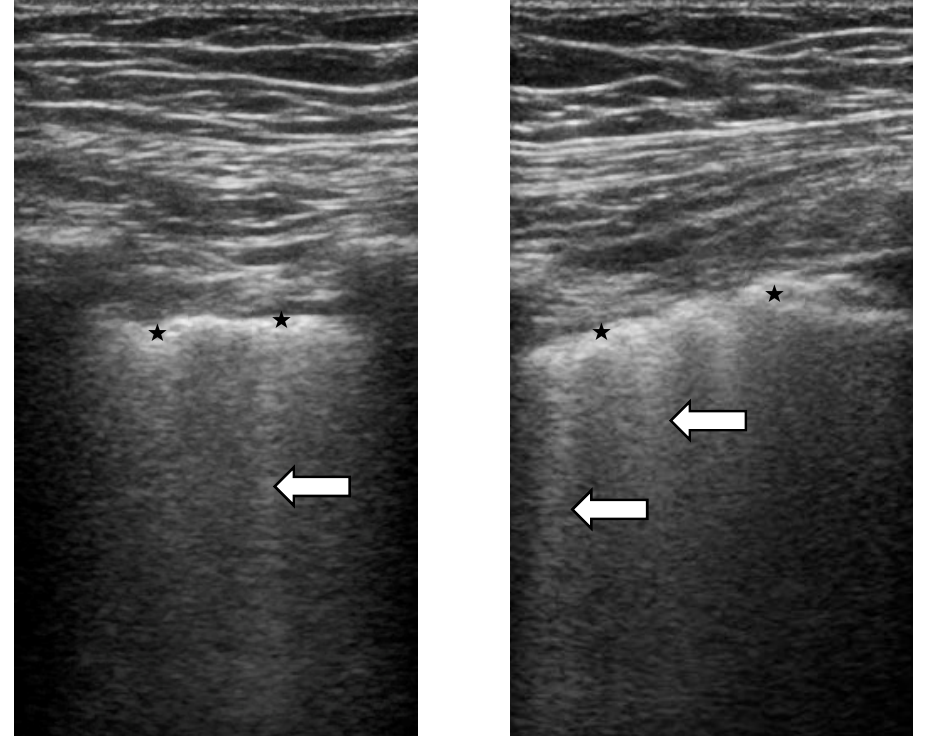
Figure 4. Ultrasonographic scans (4–13 MHz broadband linear transducer). Ultrasound B-lines (or comet-tails) are defined as hyperechogenic artefact consistent with thickened subpleural interlobular septa (white arrows). They originate from the pleural line and are roughly perpendicular to it. They have a narrow base and form a ray that spreads away from the pleural line towards the bottom of the screen and move synchronously with the lung respiration. The pathological pleural line shows irregularities ( ★ ).